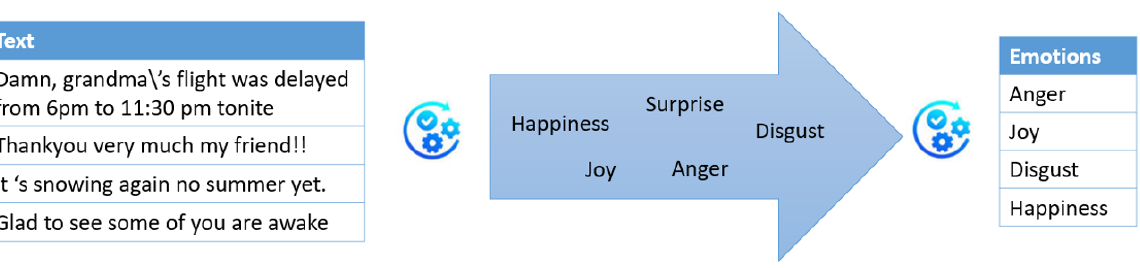
Figure 4. Pipeline of the first stage classification.